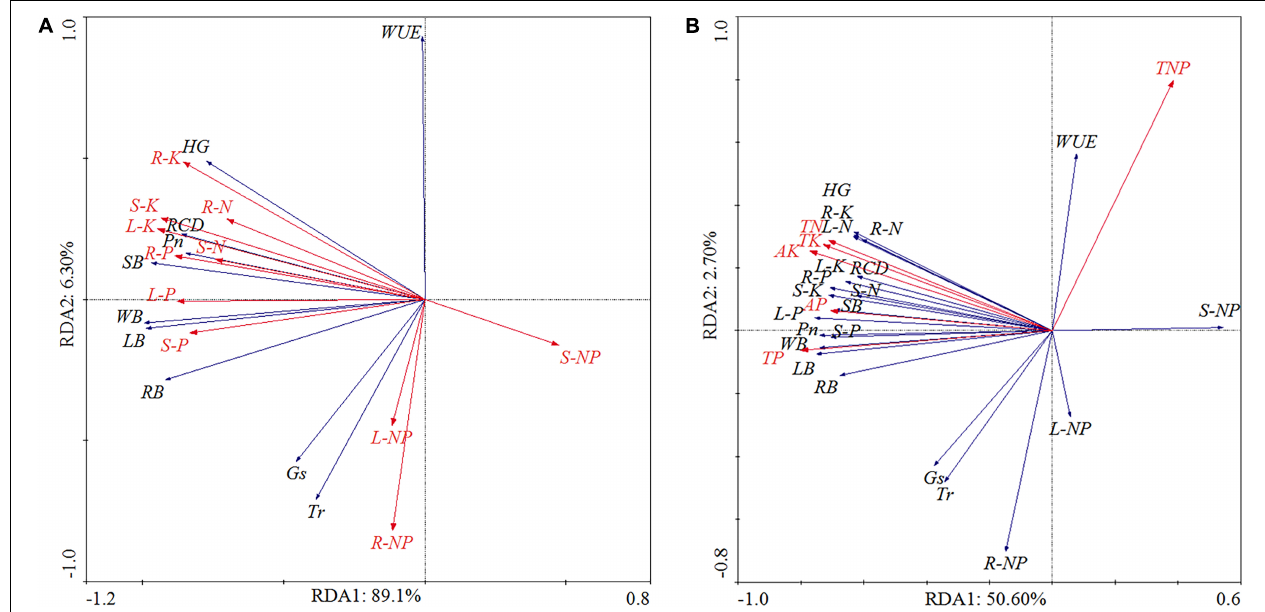
FIGURE 6 | Principal components analysis of all parameters under different fertilization treatments. Note: The relationship between the photosynthesis, growth characteristics, and nutrient content of the P. massoniana seedlings (A) ; The relationship between the soil nutrient and the photosynthesis, growth characteristics, and nutrient content of the P. massoniana seedlings (B) . Net photosynthetic rate ( P n ), stomatal conductance ( G s ), transpiration rate ( T r ), water use efficiency (WUE), height growth (HG), root collar diameter growth (RCD), root biomass (RB), stem biomass (SB), leaves biomass (LB), whole biomass (WB), nitrogen (N), phosphorus (P), and potassium